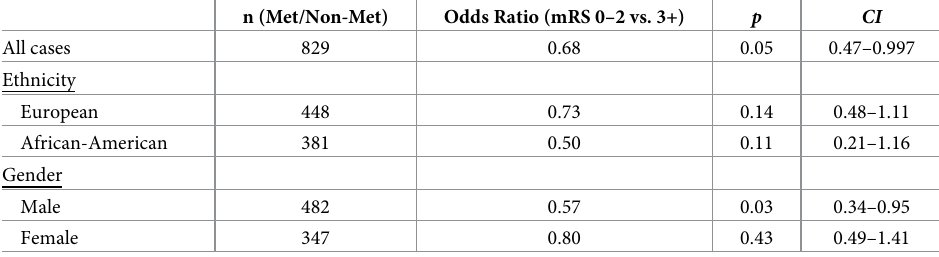
Table 2. Results of case-only analysis using an additive model that accounted for sex, age, and principal components.